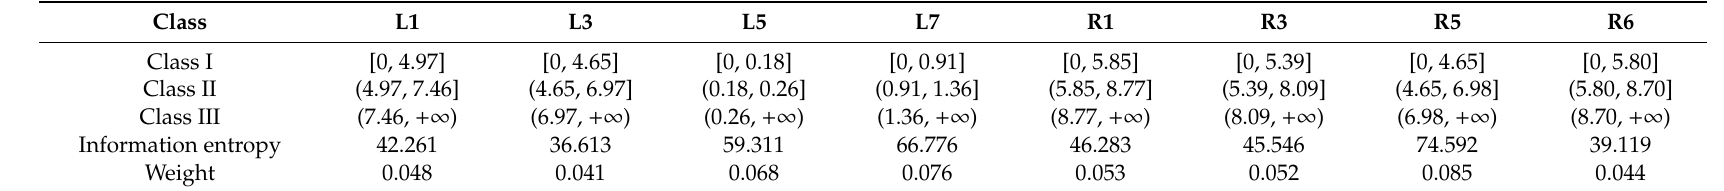
Table 4. The classification results and weights of seepage around